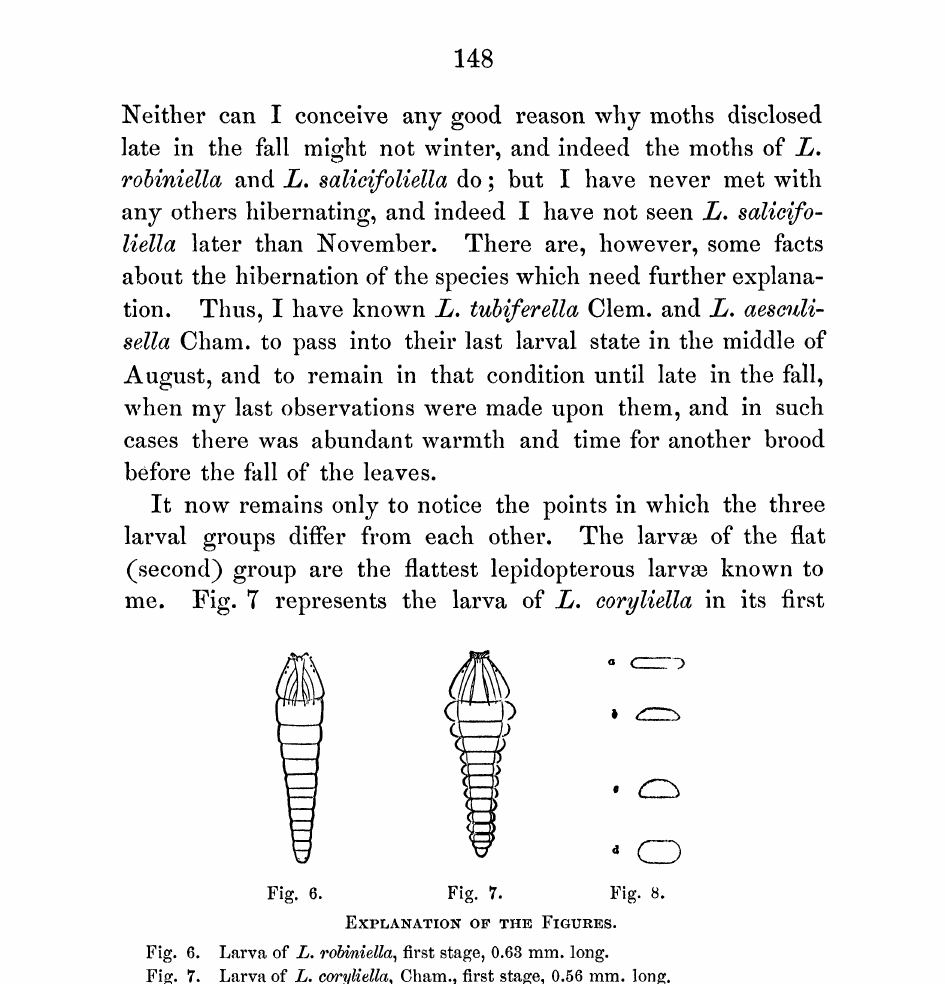
Fig. 6. Fig. 7. EXPLANATION OF THE ’IGURES. Fig. 6. Larva of .L. robiniella, first stage, 0.63 mm. long. Fig. 7. Larva of L. coryliella, Cham., first stage, 0.56 nm. long. Fig. 8. a. Outline of L. coryliella in transverse section at the fifth stage, b. Out- line of L. ornatella in transverse section at the fifth stage, c. Outline of L. ornatella in transverse section at the eighth stage immediately after the seventh moult, d. Out- line of L. robiniella in its fourth